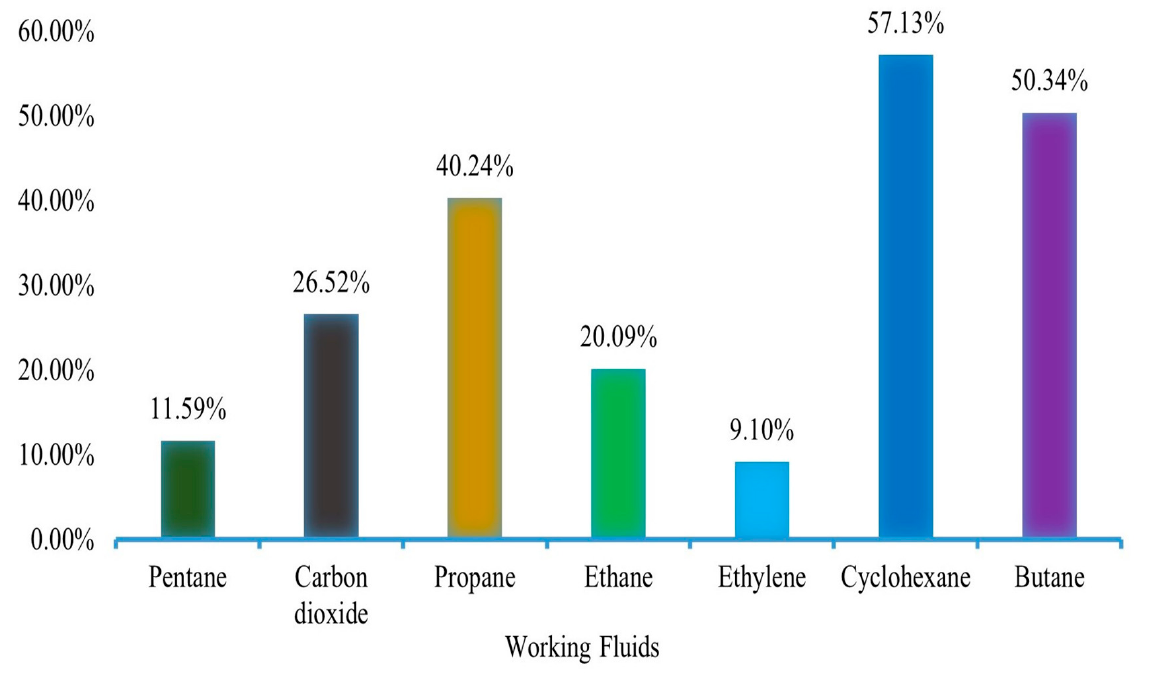
Figure 6. Demonstration on the obtained energy efficiency percentage using working fluid in a single mode.